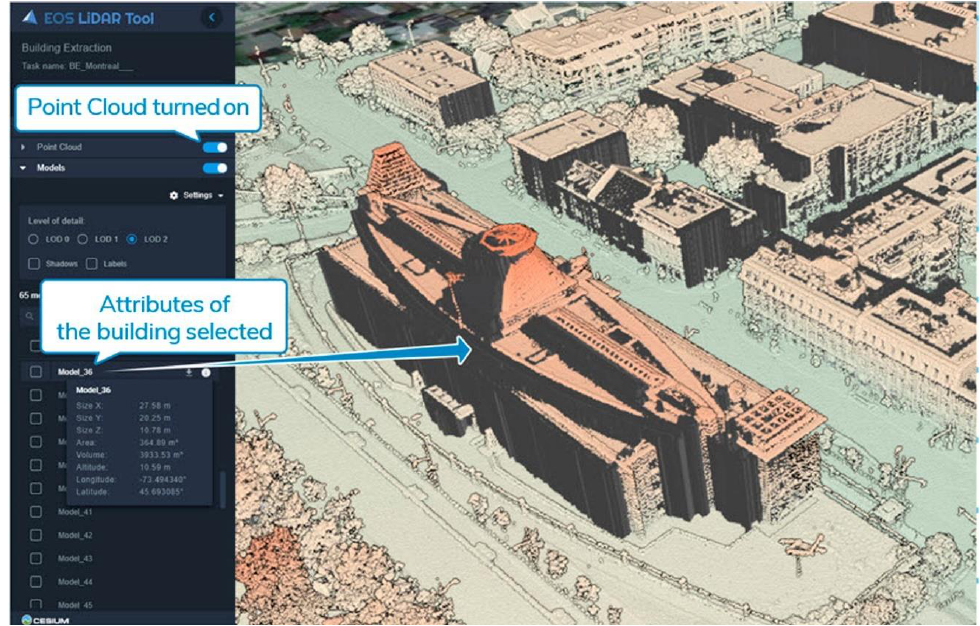
Figure 4. Visualization of both a point cloud, and HPM-building models with their attributes for a downtown of Montreal, Quebec, Canada. The visual is presented from the ELiT Server web-interface.